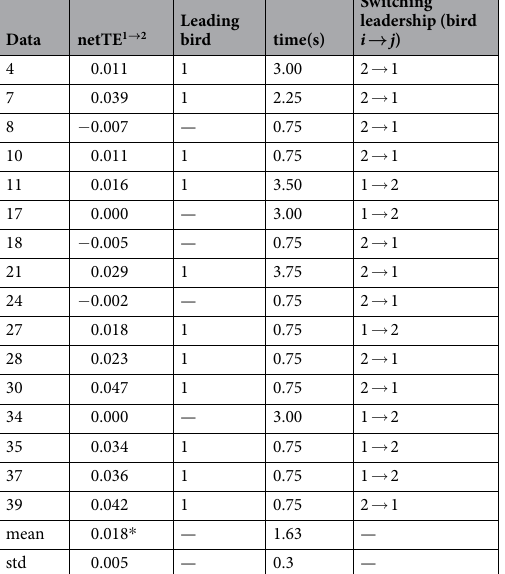
Table 5. Prediction of leadership in the tandem flight using transfer entropy over the entire length of the dataset and by implementing the intermittent leadership detection algorithm over time window length of information flow with * indicating significance using a two-tailed t-test at 5% confidence level. Third column indicates the predicted leader using traditional consistent leadership approaches in individual datasets based on the confidence interval of a t-test evaluating if bird 1 is the leader > → (netTE 0) 1 2 , or bird 2 is the leader (netTE 1 → 2 < 0). The symbol − depicts either not significantly detected as leader (column 3) or no switching event detected. Only trials with change of leadership are shown here. See Supplementary Information for all datasets in Table